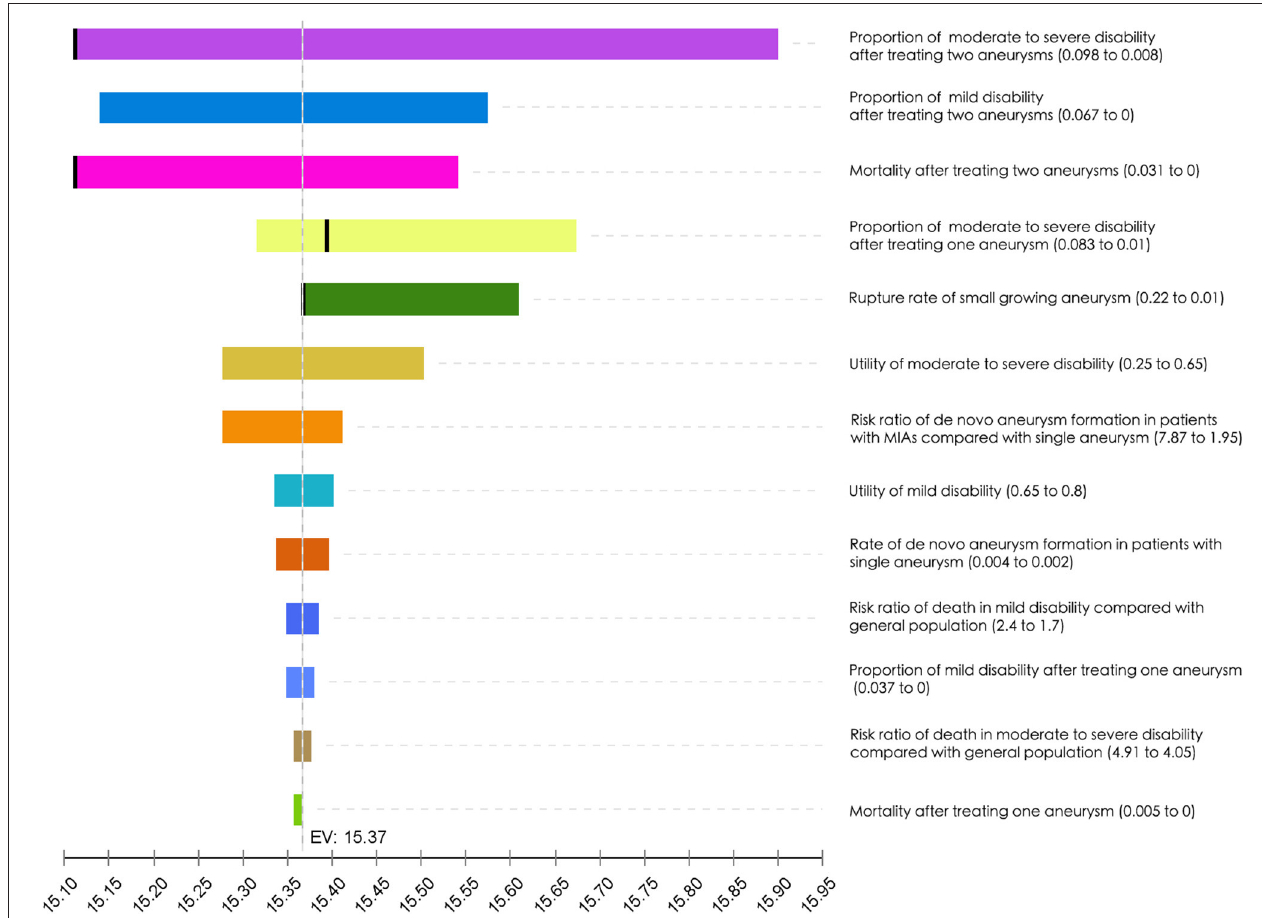
FIGURE 1 | Tornado diagram. The effect of variation of each parameter on the expected value is presented on each bar. The dark line within the bar represents the alteration of the optimal strategy. EV, expected